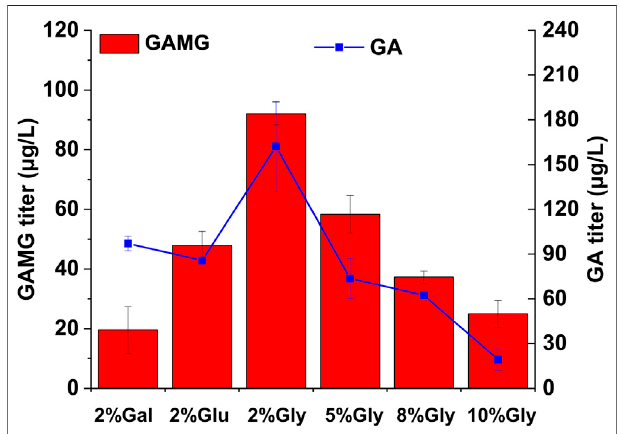
FIGURE 4 | Optimization of carbon sources for enhanced GAMG productioninyeaststrainGA15.GAMGandGAfermentationwerecarriedout in YP medium supplemented with 2% galactose, 2% glucose, or different concentration of glycerol. Error bars represent SD of biological triplicates. Gal: galactose; Glu: glucose; Gly: